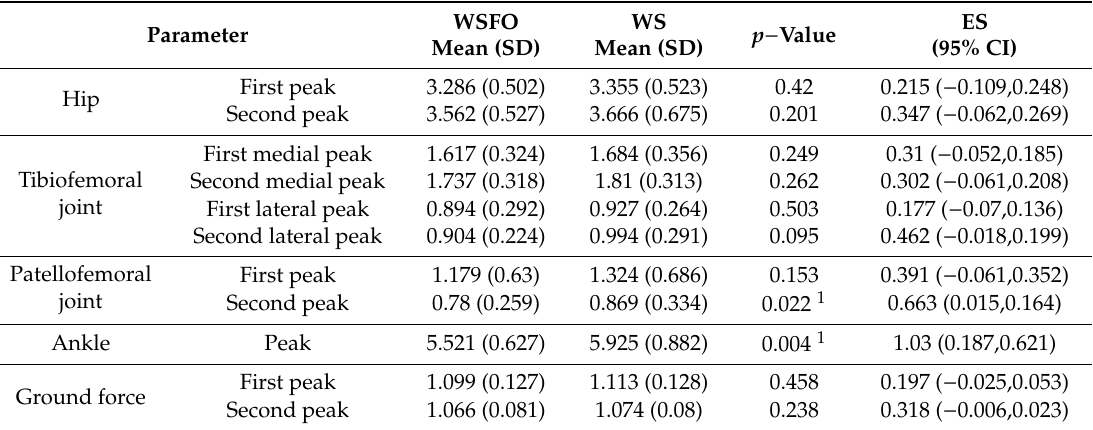
Table 3. Peak amplitude of joint force and vertical ground reaction force between two walking conditions during stance (BW).